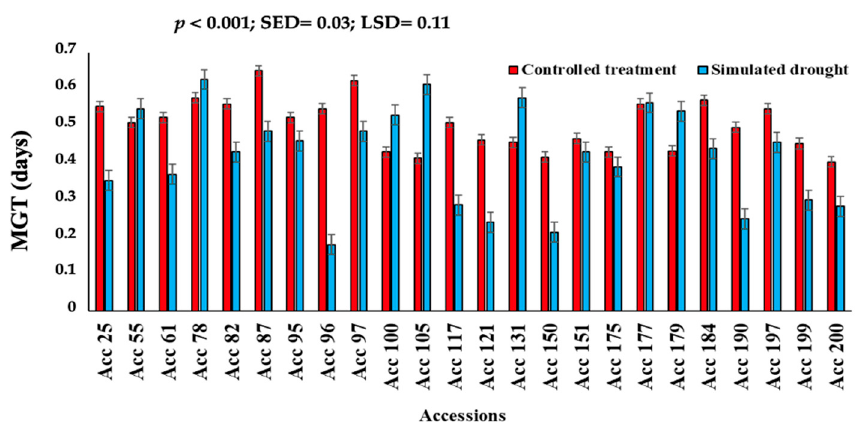
Figure 3. Mean germination time (MGT) of twenty-four Bambara groundnut genotypes subjected to simulated drought conditions using 5% PEG compared to a control treatment using distilled water.